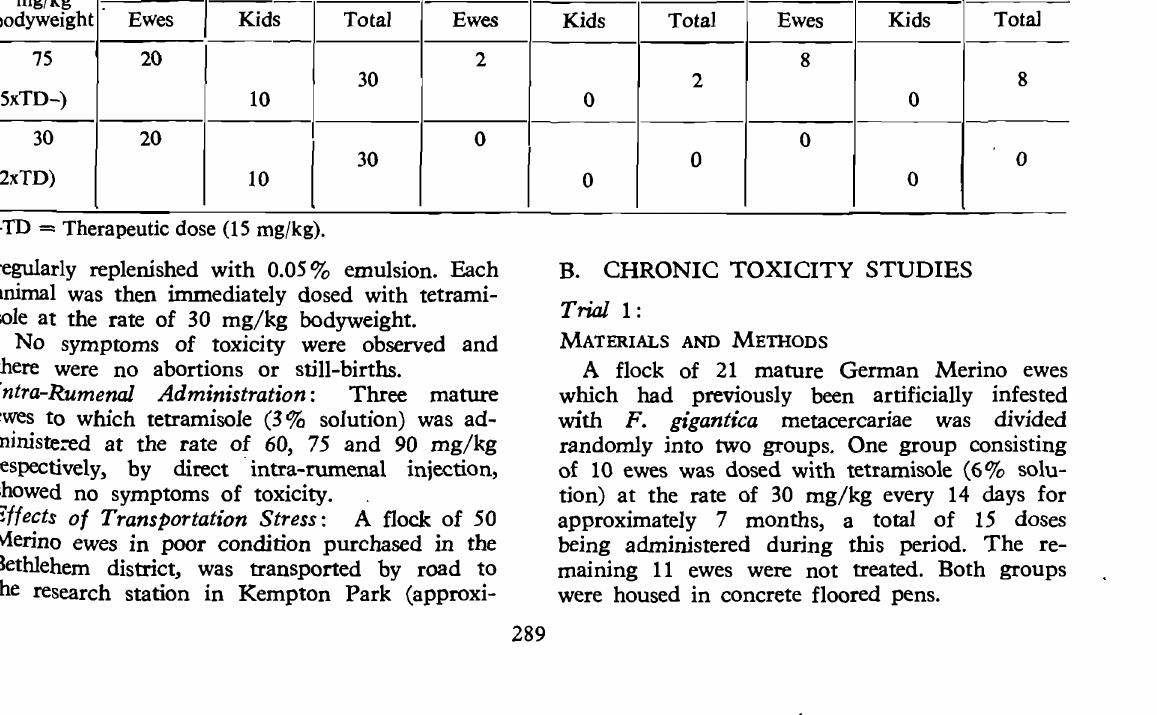
TABLE 3.-AcUTB TOXICITY STUDIES Summary of the results on the Angora goats dosed at varying levels with tetramisole